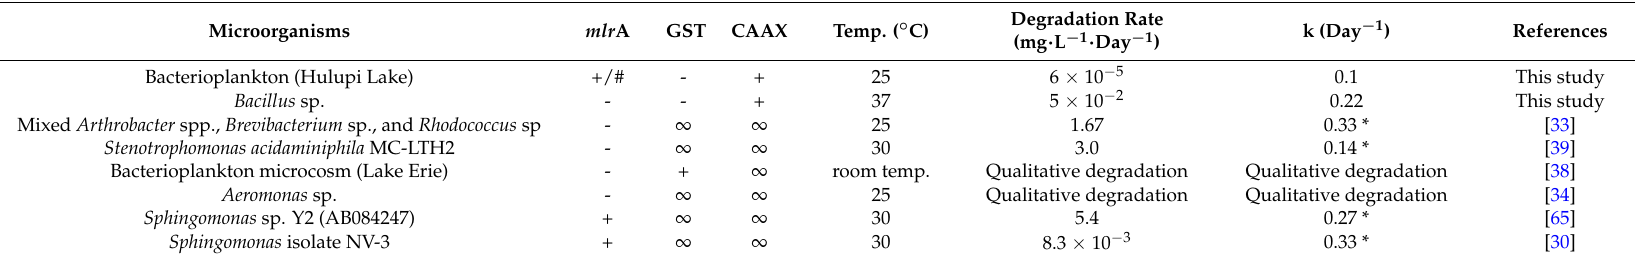
Table 2. Microorganisms involved in MC-LR degradation, with specifications of their degradation pathways via the mlr A, GST, or CAAX genes, and temperature conditions with specificity of their degradation rate and constant